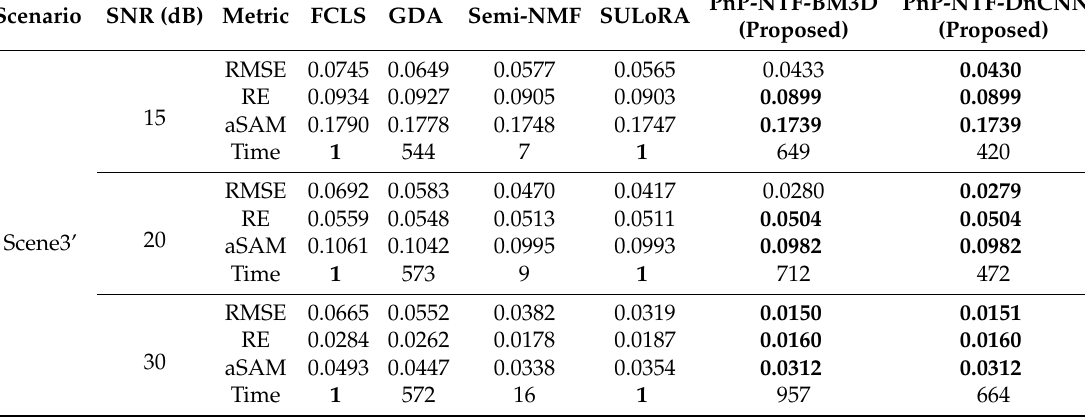
Table 3. Evaluation Results in ‘Scene3’ with different SNRs and time cost